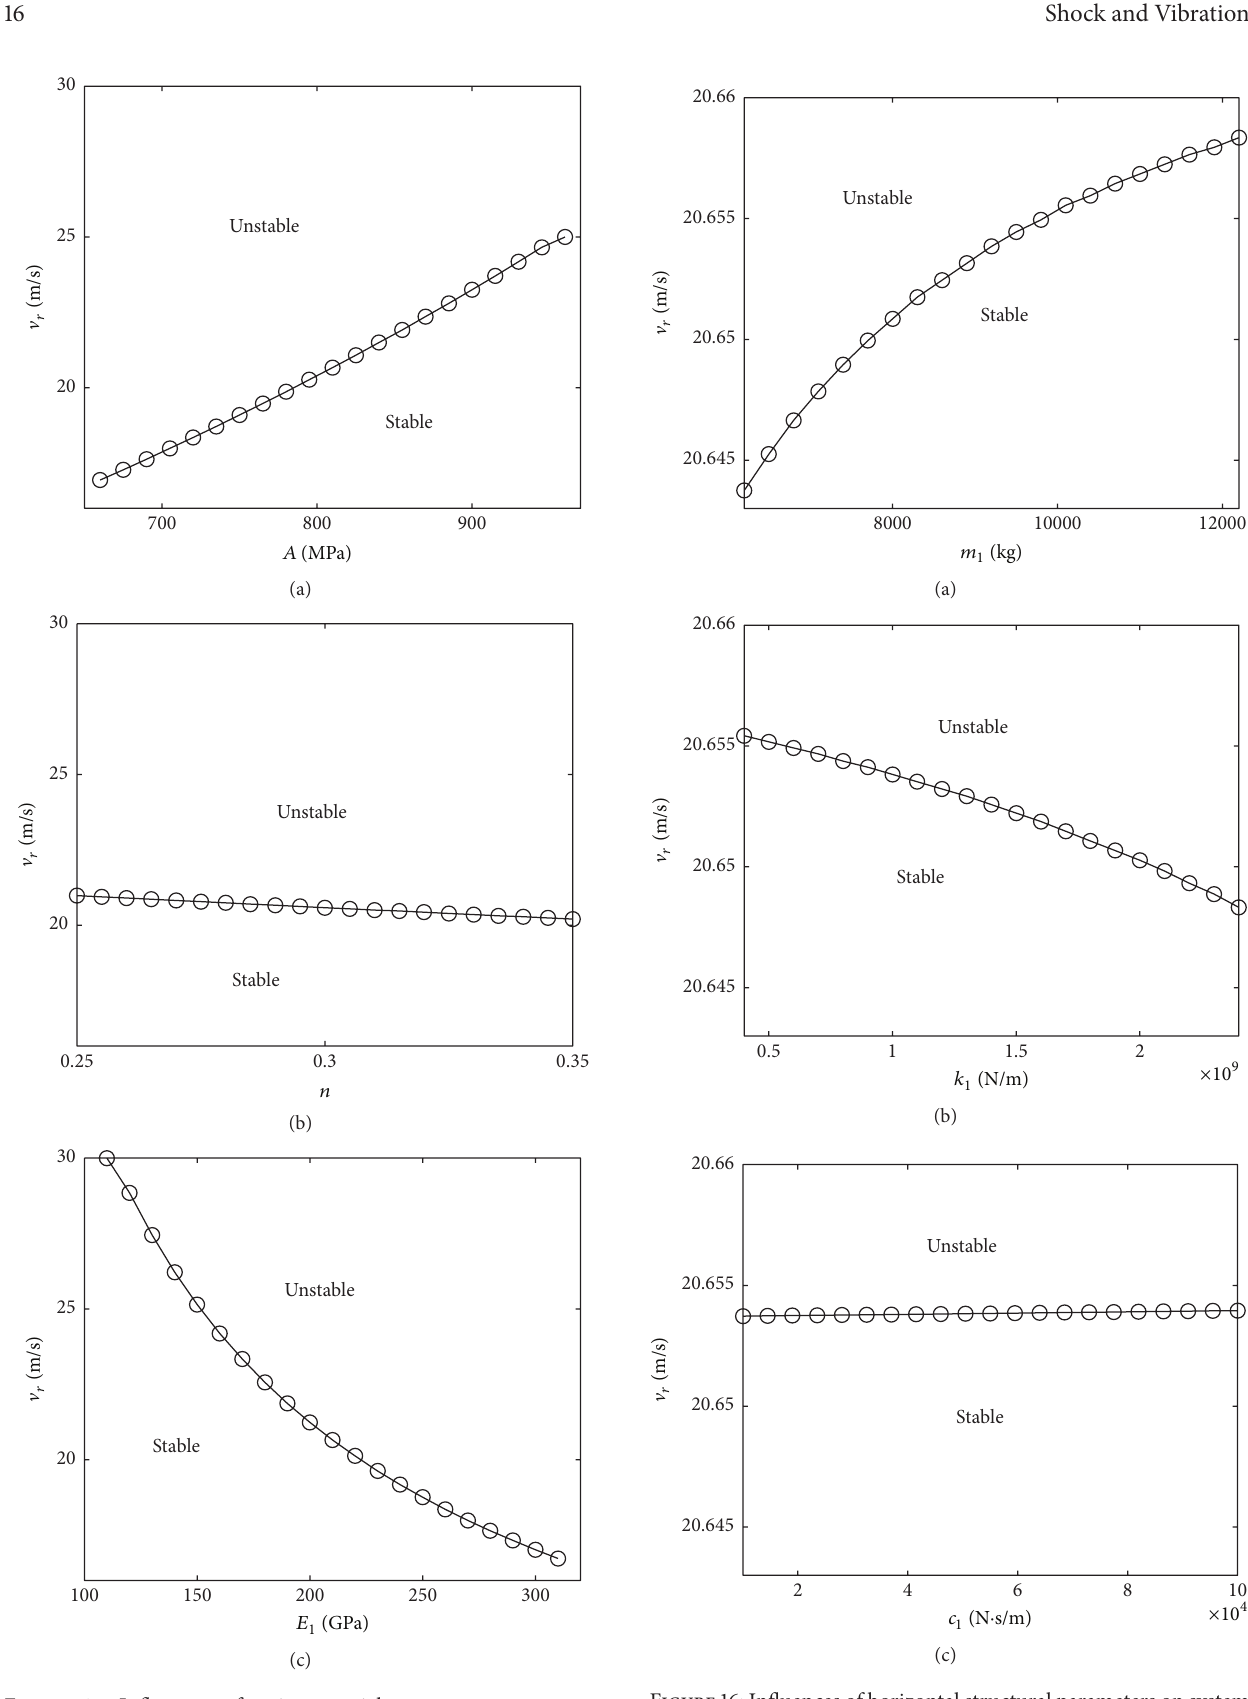
Figure 15: Influences of strip material parameters on system stability.